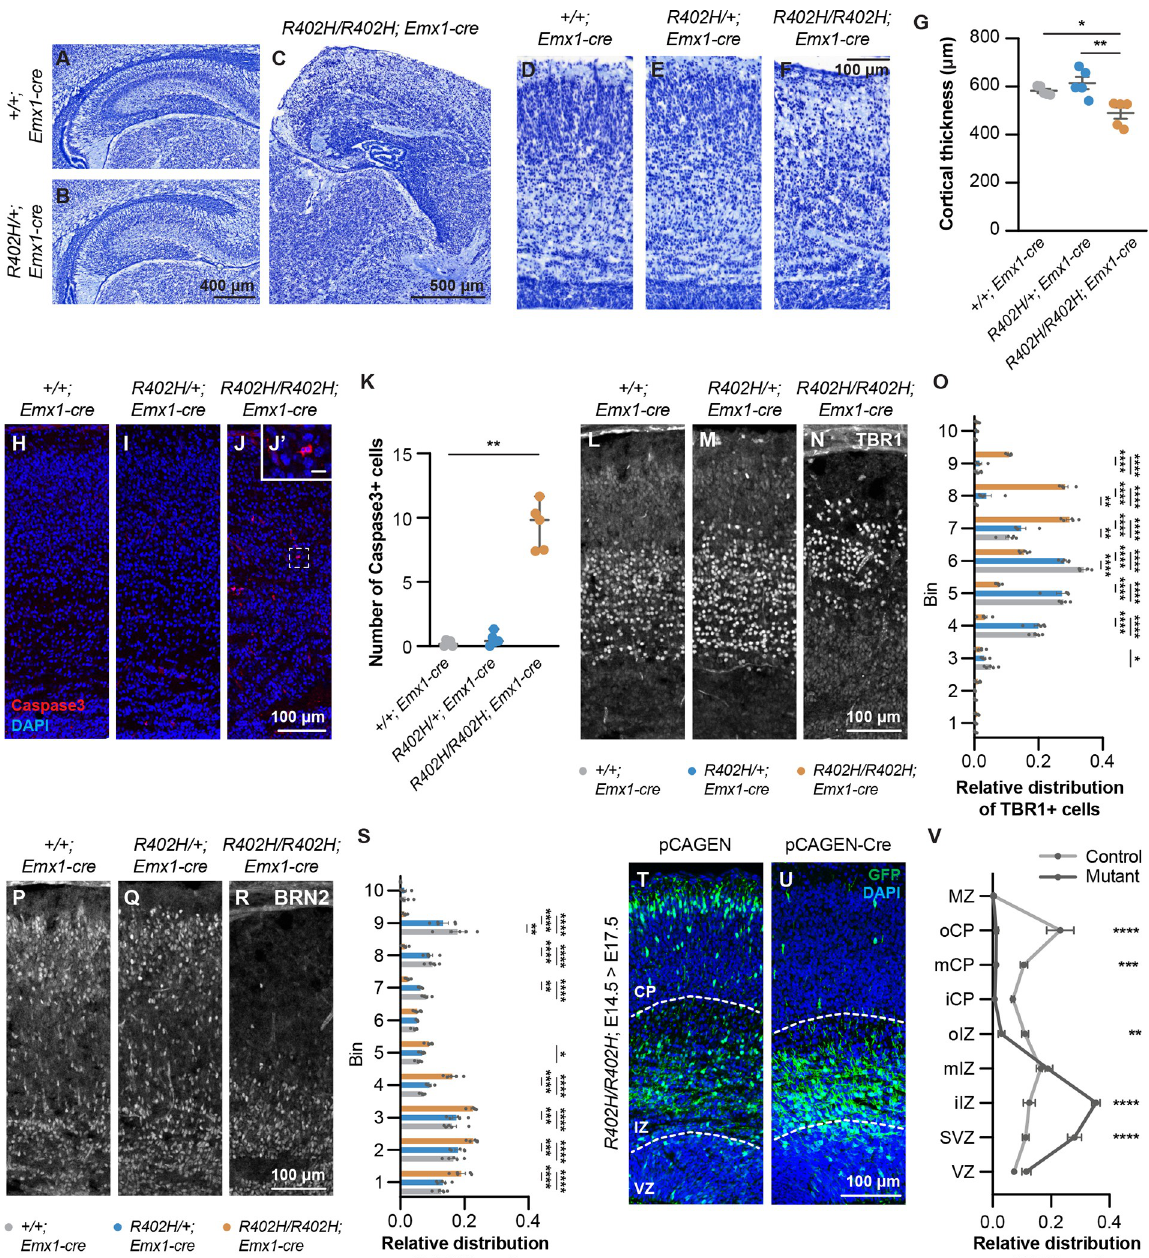
Fig 4. Homozygous expression of the R402H mutation exacerbates the migration phenotype and leads to neuronal cell death. (A-C) Nissl stained coronal sections from E18.5 embryos for (A) +/+; Emx1-cre controls, (B) R402H/+; Emx1-cre heterozygotes, and (C) R402H/R402H; Emx1-cre homozygous mutants. R402H/R402H; Emx1-cre mutants present with a severely dysmorphic hippocampus. (D-F) Nissl stained cortical sections from E18.5 embryos for (D) +/+; Emx1-cre controls, (E) R402H/+; Emx1-cre heterozygotes, and (F) R402H/R402H; Emx1-cre homozygous mutants. (G) Quantification of cortical thickness shows that R402H/R402H; Emx1-cre mutants exhibit a significant decrease in cortical thickness compared to littermates (n = 5, +/+; Emx1-cre vs. R402H/R402H; Emx1-cre P < 0.05, R402H/+; Emx1-cre vs. R402H/R402H; Emx1-cre P < 0.01). (H-J) Representative E18.5 sections stained with cleaved caspase-3. (K) Quantification of caspase-3-positive cells reveals a significant increase in R402H/R402H; Emx1-cre mutants compared to littermates (n = 5, +/+; Emx1-cre vs. R402H/R402H; Emx1-cre P < 0.01). (L-N) Representative E18.5 sections stained with an antibody that targets TBR1 (which labels deep layer neurons) and (P-R) an antibody against BRN2 (which labels upper layer late-born neurons). (O, S) Quantifications showing the relative distribution of TBR1+ and BRN2+ cells across the developing cortex. In R402H/R402H; Emx1-cre homozygous mutants there was a cortical inversion, with BRN2+ neurons accumulating in the intermediate zone, and TBR1+ neurons present in the superficial layers (n = 5, see S1 Table). (T-V) R402H/R402H animals were electroporated with either a pCAGEN control vector or pCAGEN-Cre at E14.5 and the embryos collected at E17.5. (V) Relative distribution of